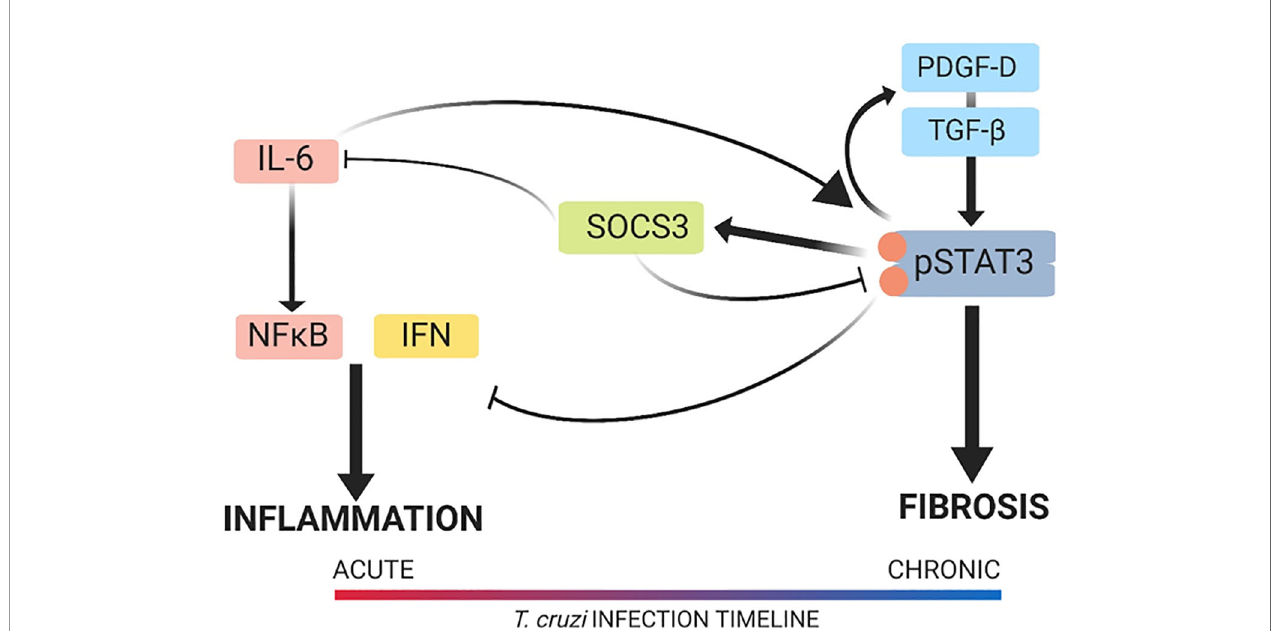
FIGURE 10 | Signal transducer and activator of transcription-3 (STAT3) modulation of the cardiac in fl ammatory – fi brotic axis in chronic Chagasic cardiomyopathy (CCC). Depicted is the cardiac pathology continuum that starts in the acute phase with a predominantly in fl ammatory response in the heart, which develops into a predominantly fi brotic response in the heart with progression into chronic disease. The role of STAT3 and its upstream and downstream signaling mediators is also depicted. In our model of CCC, STAT3 was found to promote fi brosis via transforming growth factor beta (TGF- b ) and platelet-derived growth factor (PDGF) signaling while suppressing in fl ammatory signaling that involved interferon- g (IFN- g ) and interleukin-6 (IL-6). Upon inhibition of STAT3, in fl ammation increased and fi brosis decreased in the heart. The image was created with the assistance of